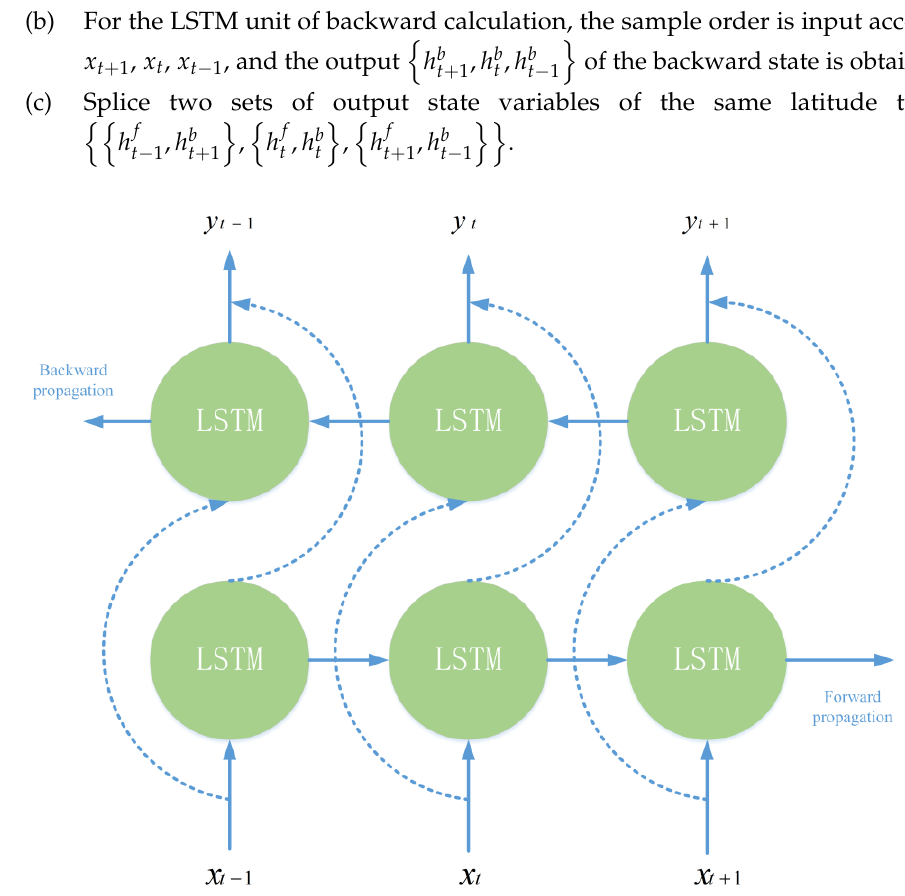
(10) Table 1. Network structure parameters. Parameter